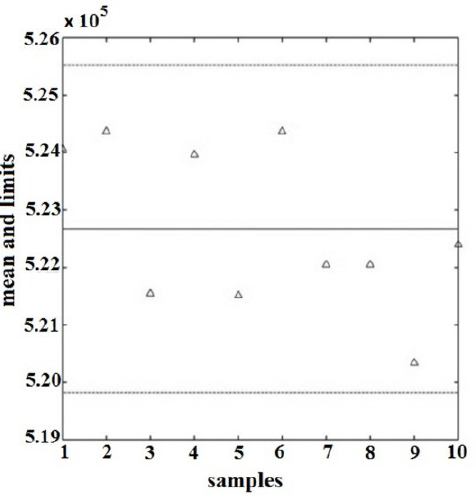
Fig. 4. Relative standard uncertainty versus the means of I V in circle and of four catalyst